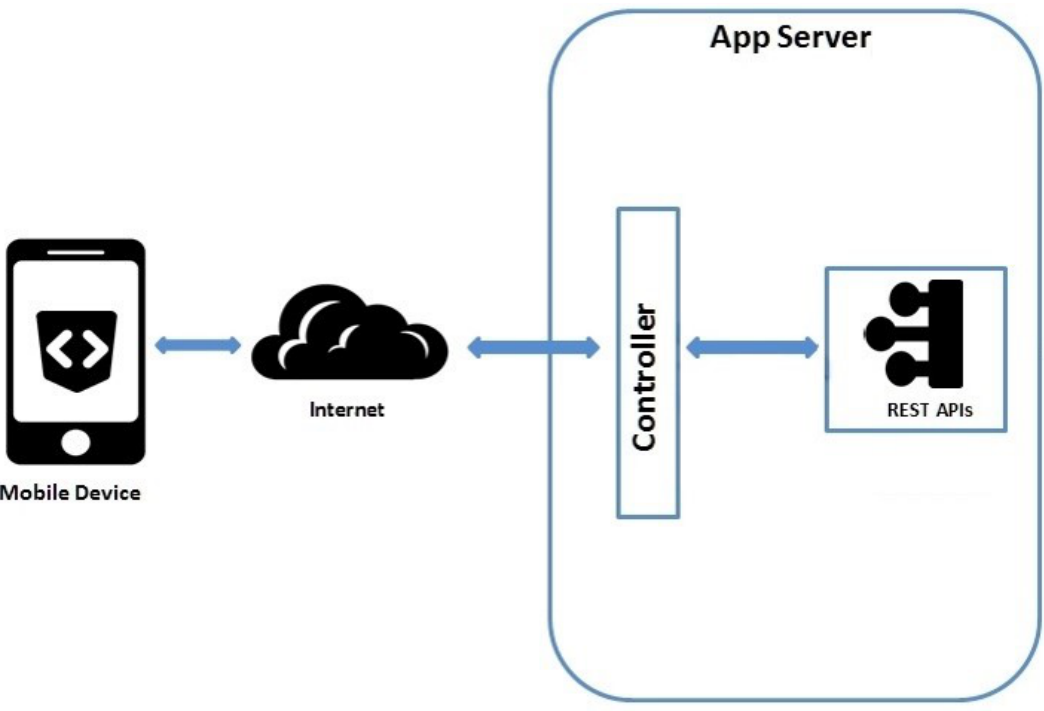
Figure 3. Mobile application